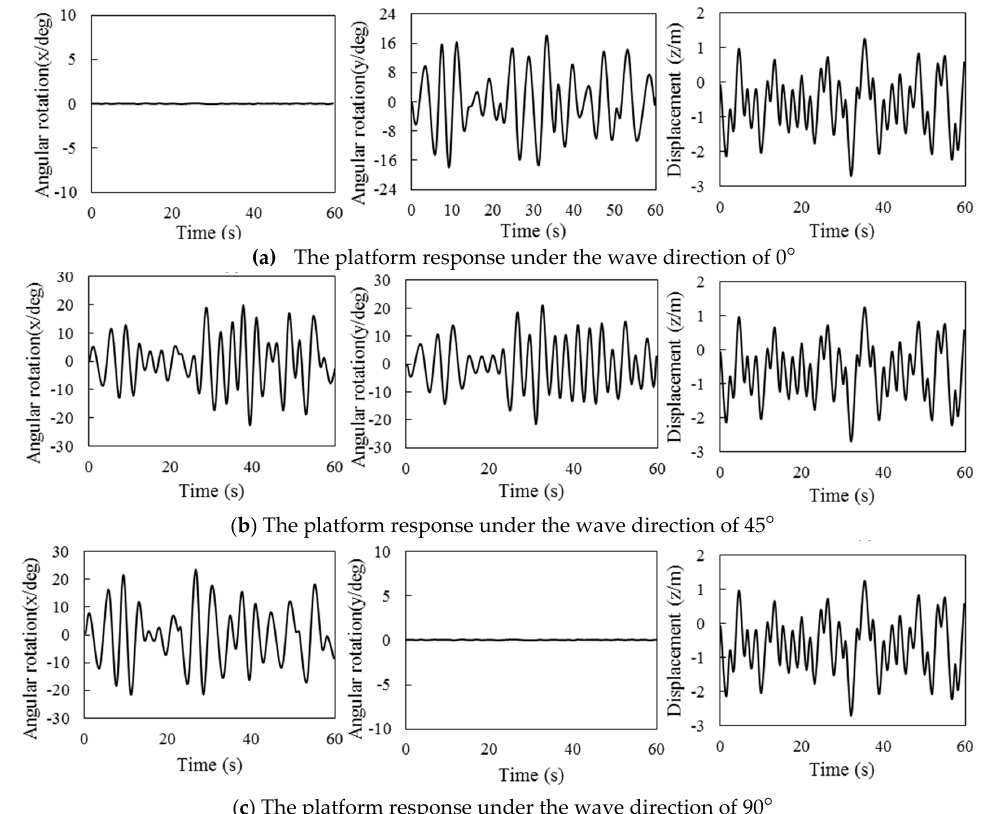
Figure 7. The platform response under wind − sea scale 5 with different wave directions.